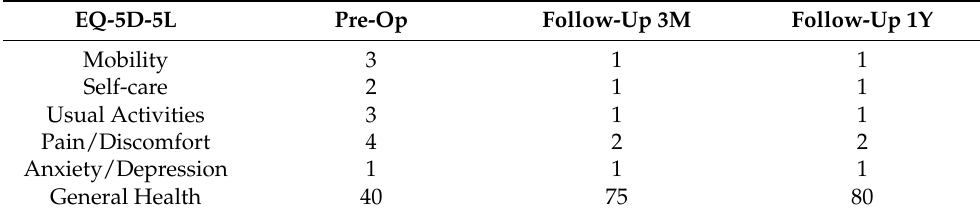
Table 7. EQ-5D-5L values for the pre-operative and follow-up related quality of life evaluation. The five domains’ data range is from 1 to 5. General Health is represented by a visual analog scale range from 0 to